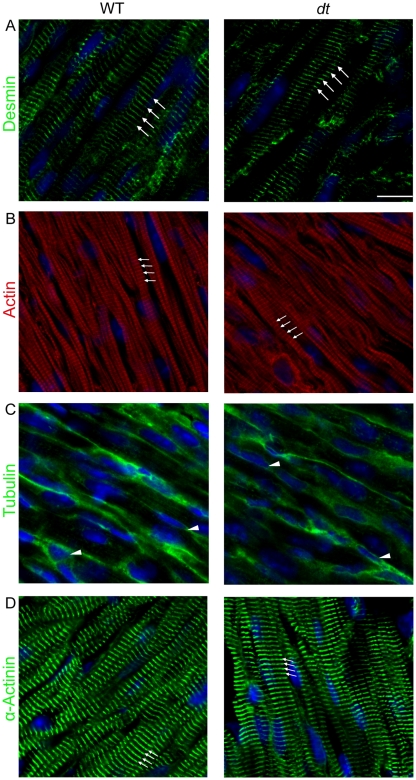
Localization of desmin intermediate filaments, microfilaments, microtubules and α-actinin in longitudinal heart sections from P14 wt and dt mice.A total of four wt and four dt hearts were processed for immunofluorescence in three separate experiments. Approximately 40 cardiomyocytes were analyzed from one field of view taken from each wt and dt sample. (A) Desmin striations and interstriation spacing are comparable in both wt and dt samples (arrows). (B) The microfilament striation patterns are also very similar in both wt and dt cardiac myocytes. (C) The microtubule network is visible at the perinuclear regions (arrowheads) and near the sarcolemma in both wt and dt samples. (D) Alpha-actinin staining was performed to determine the integrity of Z-discs. The staining pattern of α-actinin was similar for both wt and dt samples. The nuclei were labeled using DAPI (shown in blue). Scale bar  = 20 µm for all images. N = 4 per group for A–C and N = 3 for D.